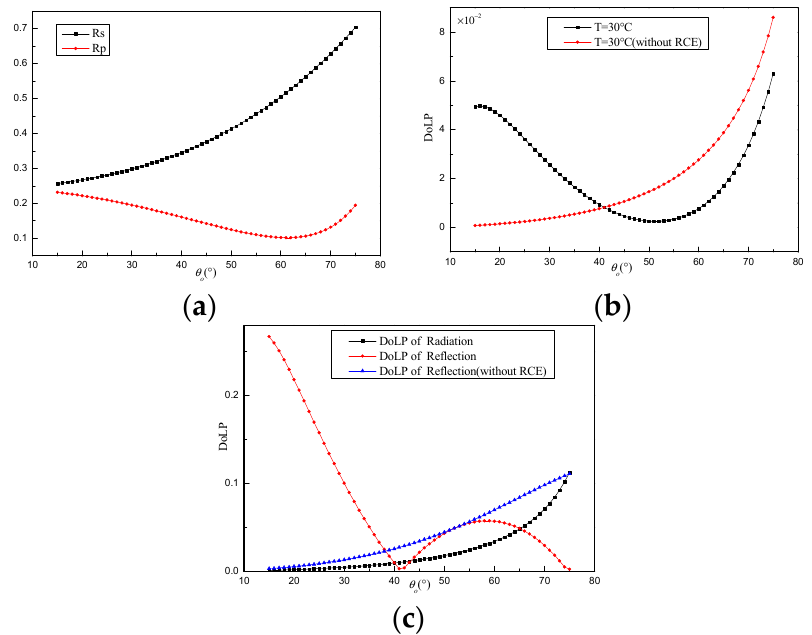
Figure 3. Influence of RCE on the DoLP of object: ( a ) Reflectance of the s-polarized and p-polarized components; ( b ) the DoLP of the object; and ( c ) the DoLP of reflection and radiation.